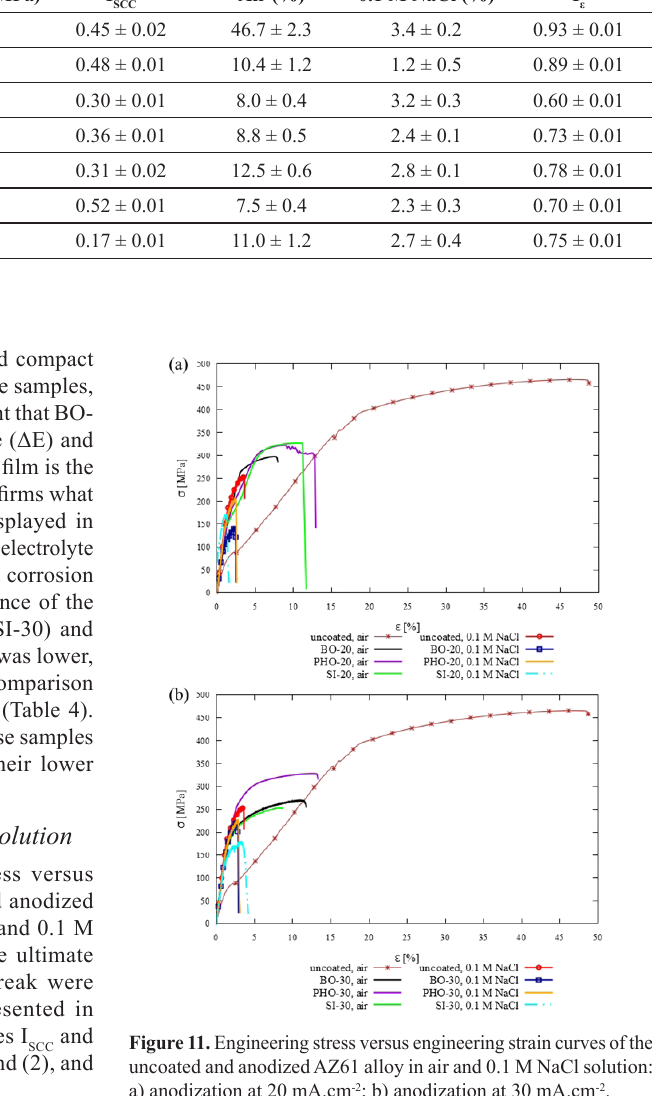
Table 5. Tensile properties and susceptibility indices of the uncoated and anodized AZ61 alloy for tests conducted in air and 0.1 M NaCl solution at room temperature. Sample